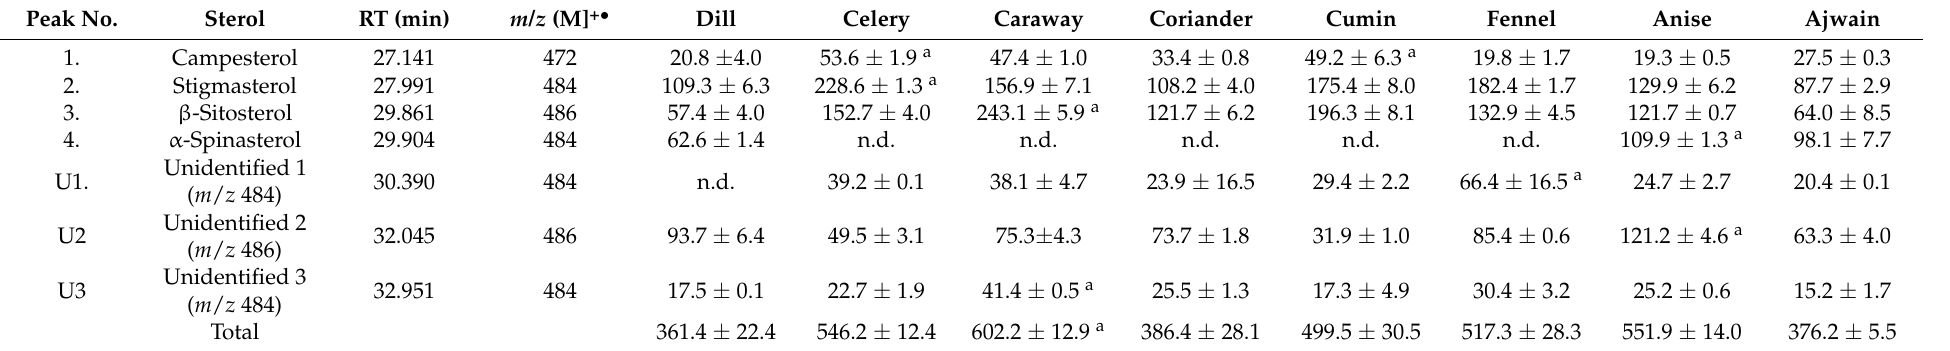
Table 1. Phytosterol composition of studied spices (mg/100 g of